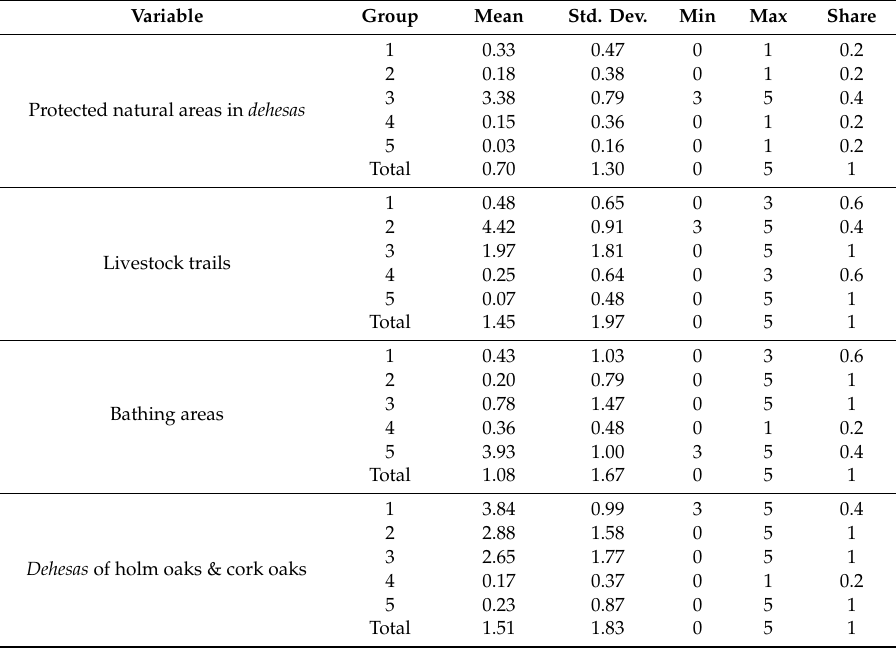
Table 7. Overall variable statistics.